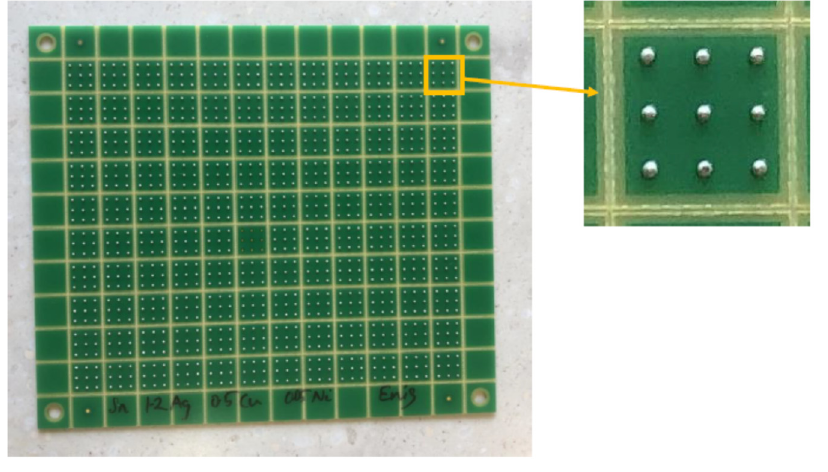
Figure 2. Test Figure 2. Test board.